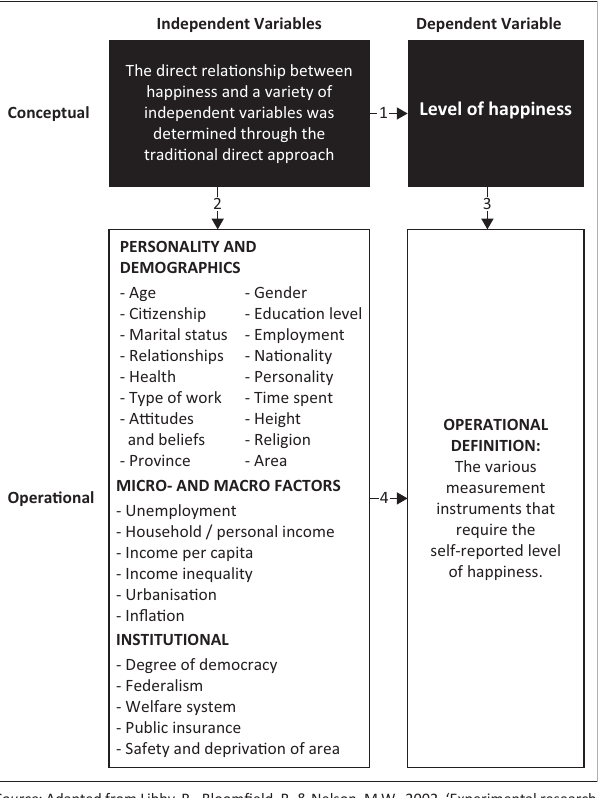
FIGURE 5: Predictive validity framework of happiness.